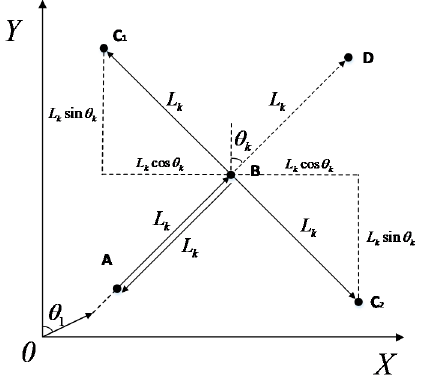
Figure 5. Multi-pattern dead reckoning.